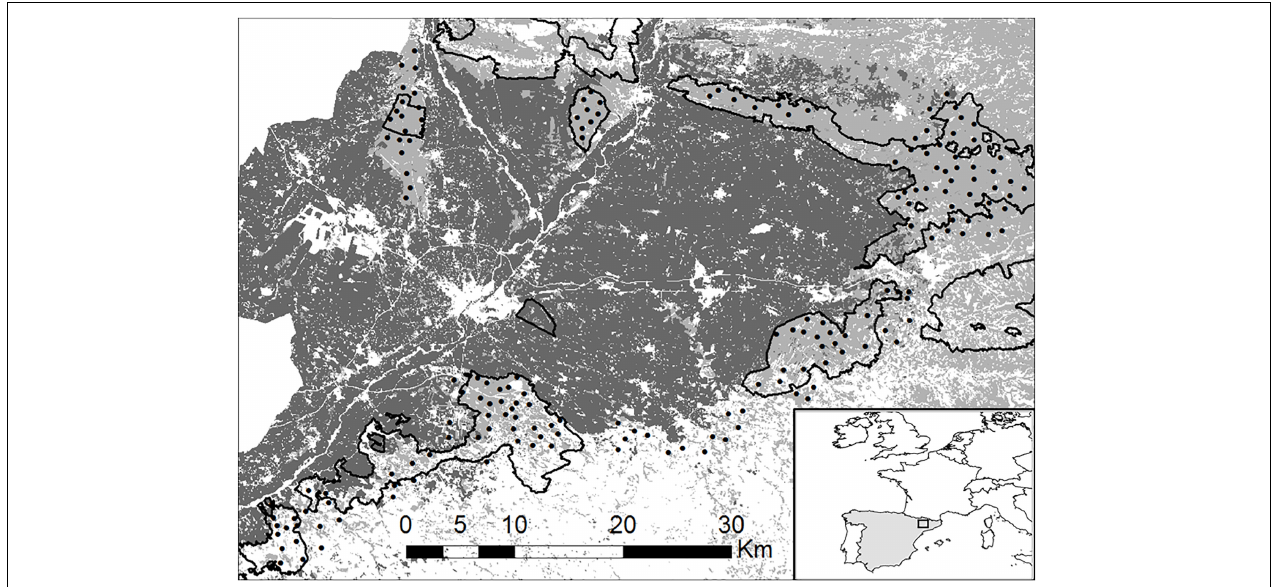
FIGURE 1 | Location of the study area in NE Spain and distribution of the 500 m transects (points) across the studied dry cereal farmland areas (lighter colored areas). Intermediate and dark gray areas represent irrigated herbaceous crops and orchards and white areas represent other land uses (urban, etc.). Polygons represent the Special Protected Areas included in Natura 2000